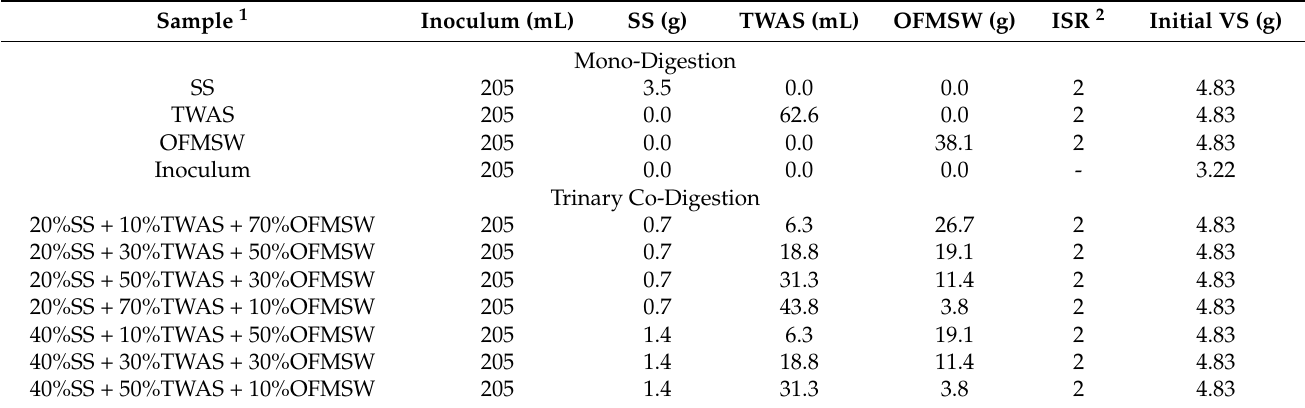
Table 1. The experimental design used in this